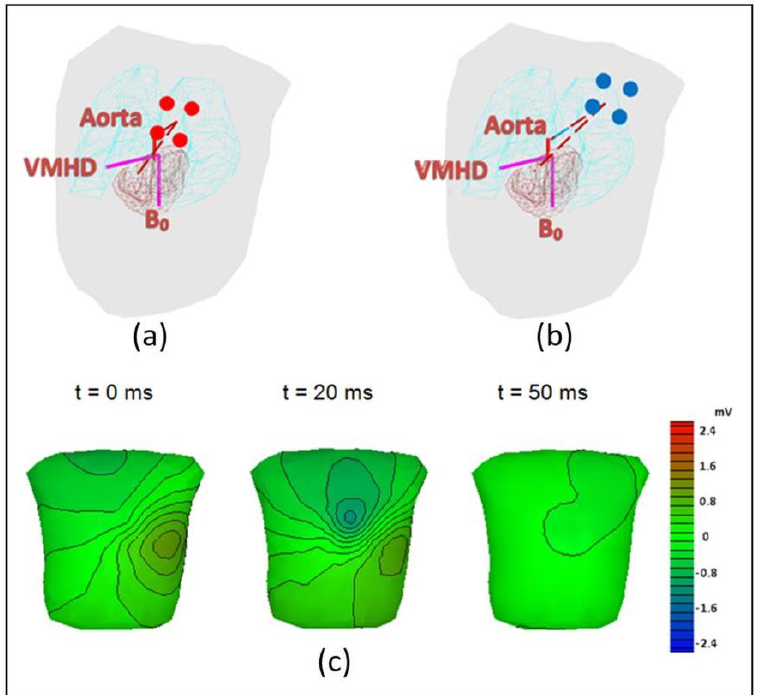
Figure 3. Results of optimization routine for determining optimal electrode placement with respect to minimization of induced V MHD . ( a ) Standard electrode placement for ECG gating (red). Electrical vector from electrodes is nearly unobscured from heart and aorta by the lungs. ( b ) V MHD -minimized electrode placements (blue). Electrical vector is in view of heart but remains obscured from aorta by superior lobe of the lung. ( c ) Body surface maps of the R-wave amplitudes predicted by ECGSIM when taking ECG using the V MHD -minimized electrode placements, where t = 0 is the onset of the R peak.